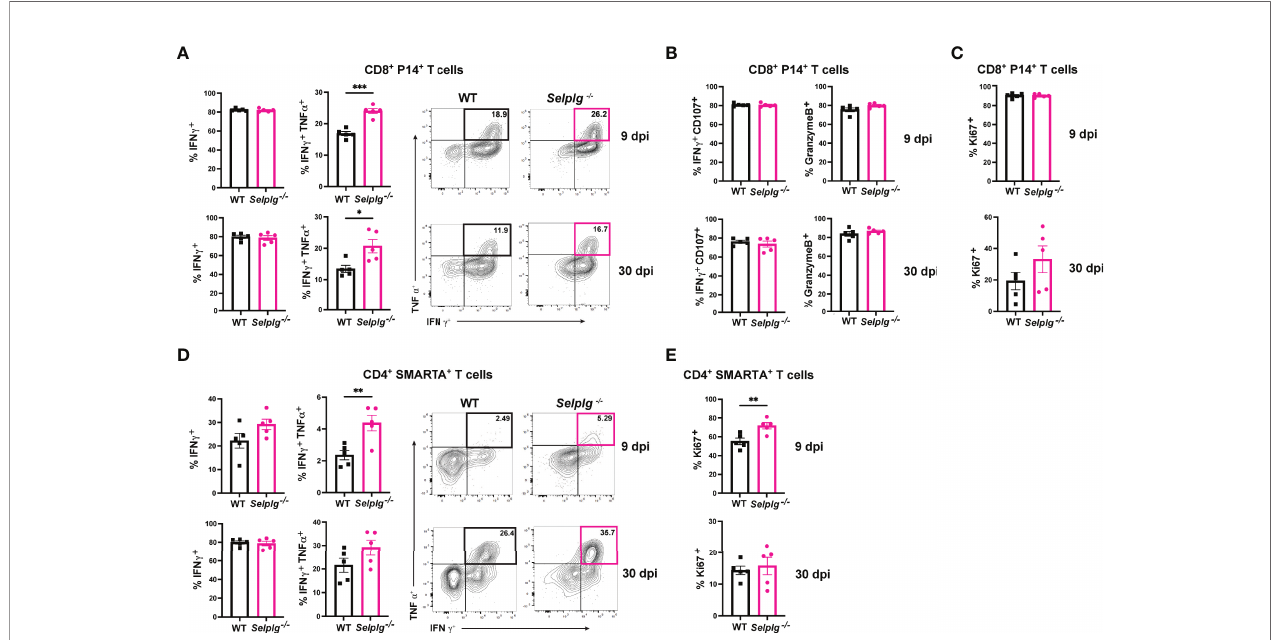
FIGURE 2 | PSGL-1-de fi cient CD4 + and CD8 + T cell effector functions. Spleens were isolated from Cl13 infected mice at 9 and 30dpi and ex vivo stimulated with cognate peptide. Frequency of IFN- g + and IFN- g + TNF- a + of WT and Selplg -/- P14 + T cells (A) . Frequencies of IFN- g + CD107 + and GranzymeB + (B) and Ki67 + (C) WT and Selplg -/- P14 + T cells. Frequencies of IFN- g + and IFN- g + TNF- a + WT and Selplg -/- SMARTA + T cells (D) . Frequencies of Ki67 + WT and Selplg -/- SMARTA + T cells (E) . *p < 0.05, **p < 0.01, ***p < 0.001, (unpaired t -test). Data are representative of four independent experiments all with fi ve or more mice per group (error bars,